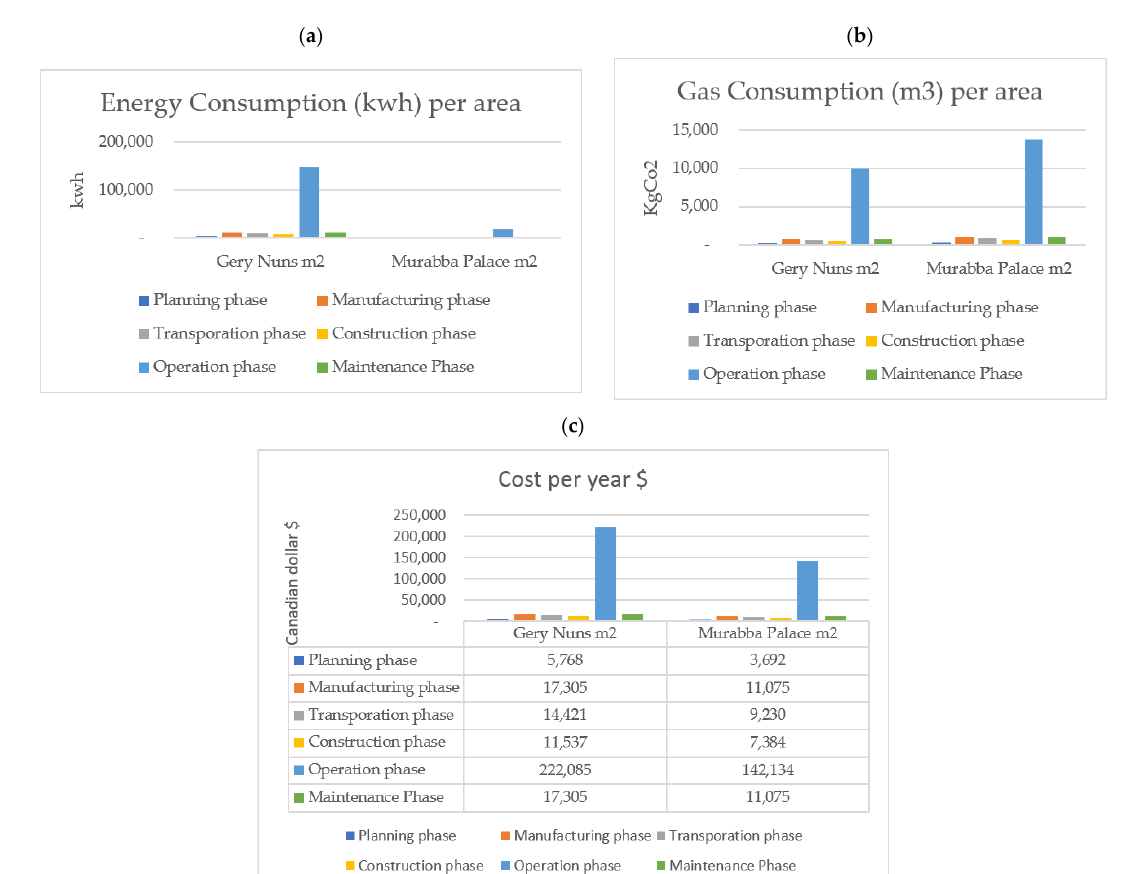
Figure 7. Cost in the life-cycle phases of both case studies. ( a ) Electricity consumption in the life-cycle phases of both case studies. ( b ) Gas consumption in the life-cycle phases of both case studies. ( c ) Cost in the life-cycle phases of both case studies.